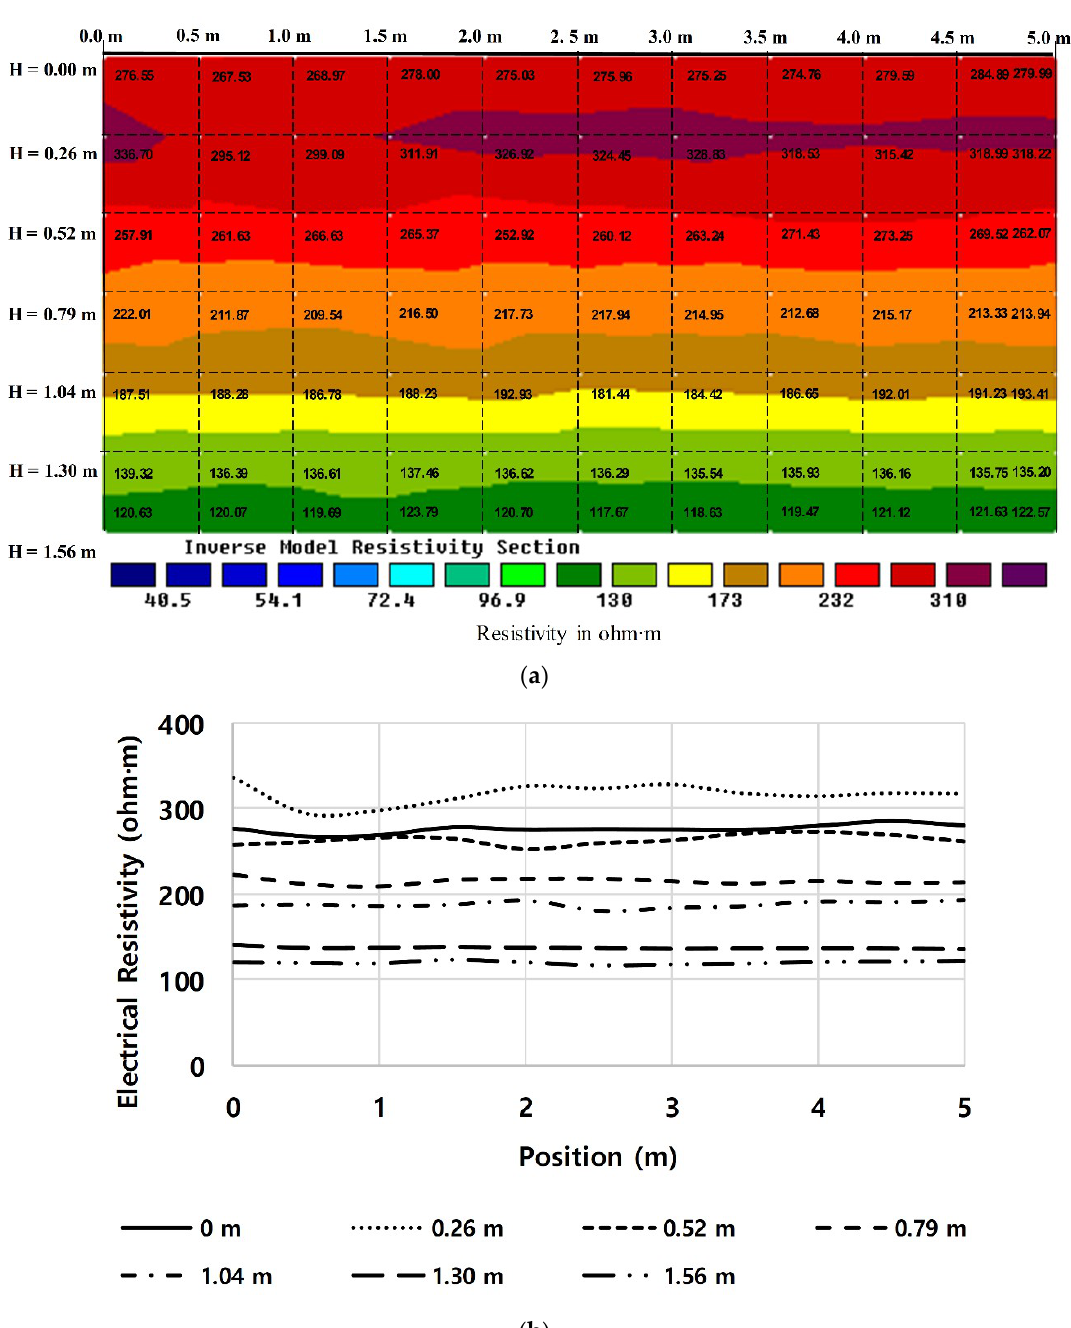
Figure 5. Test result for natural ground (Section No. 1). ( a ) Distribution of the electrical resistivity (ER). ( b ) ER according to the position at each depth.